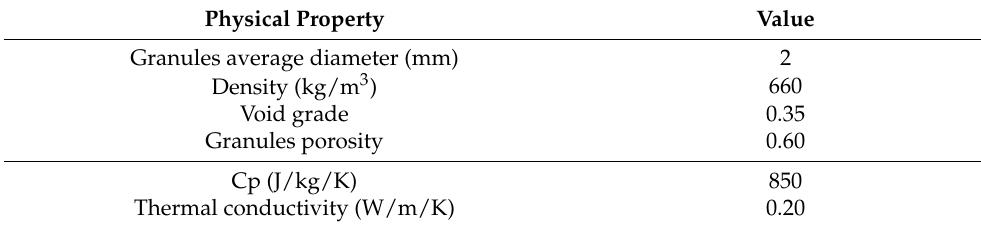
Table 1. Physical properties of the provided zeolites 13X-Fe.